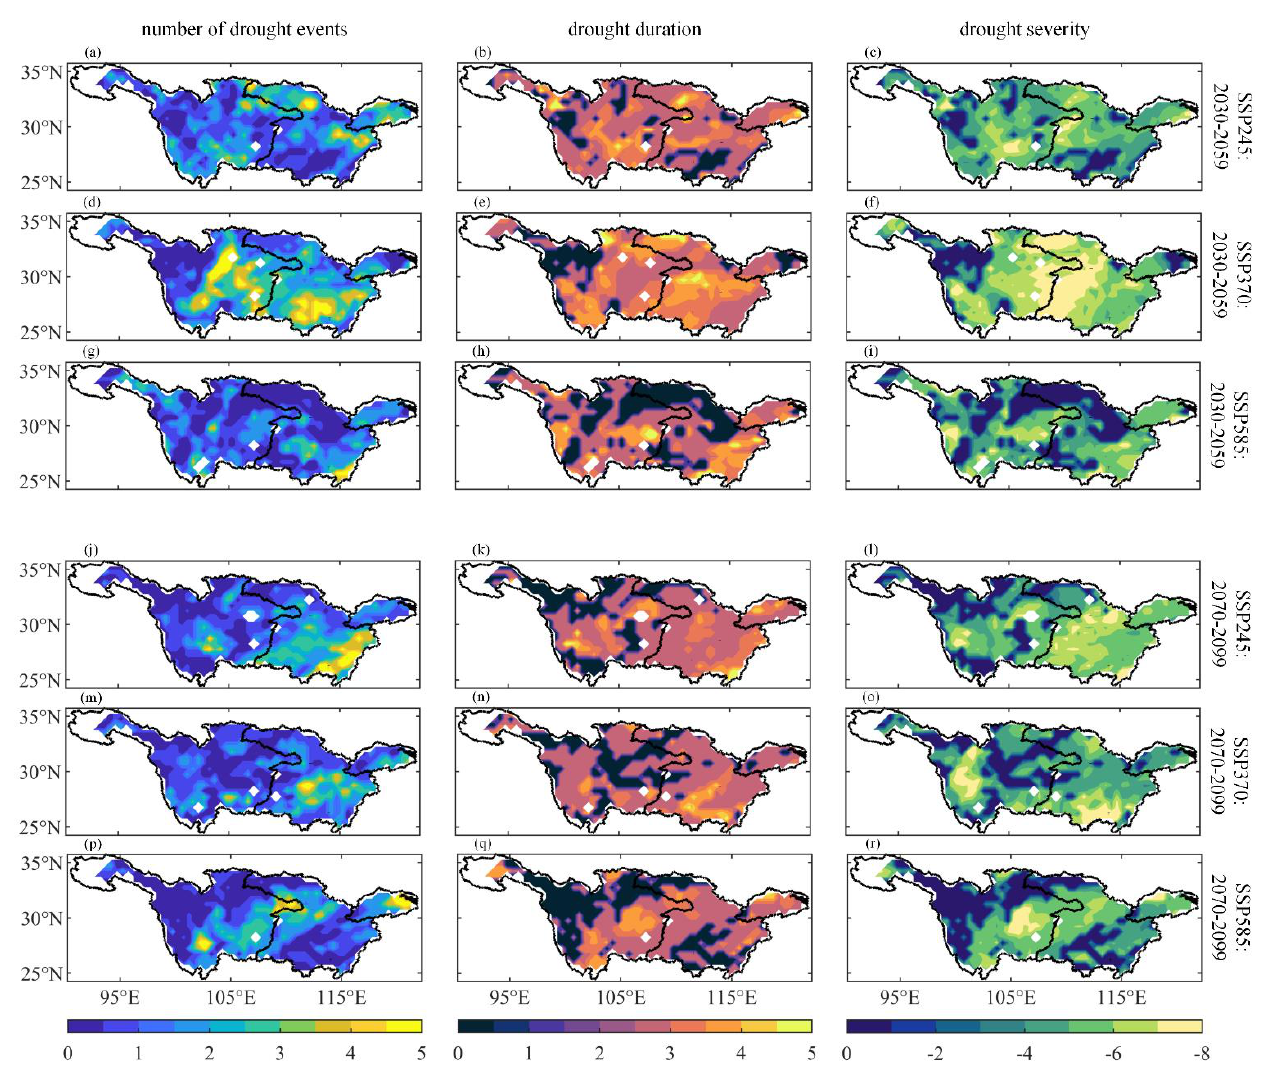
Figure 4. Spatial distribution of the number of drought events ( a , d , g , j , m , p ), average duration ( b , e , h , k , n , q ), and average severity ( c , f , i , l , o , r ) in the 1-month scale in the Yangtze River basin from